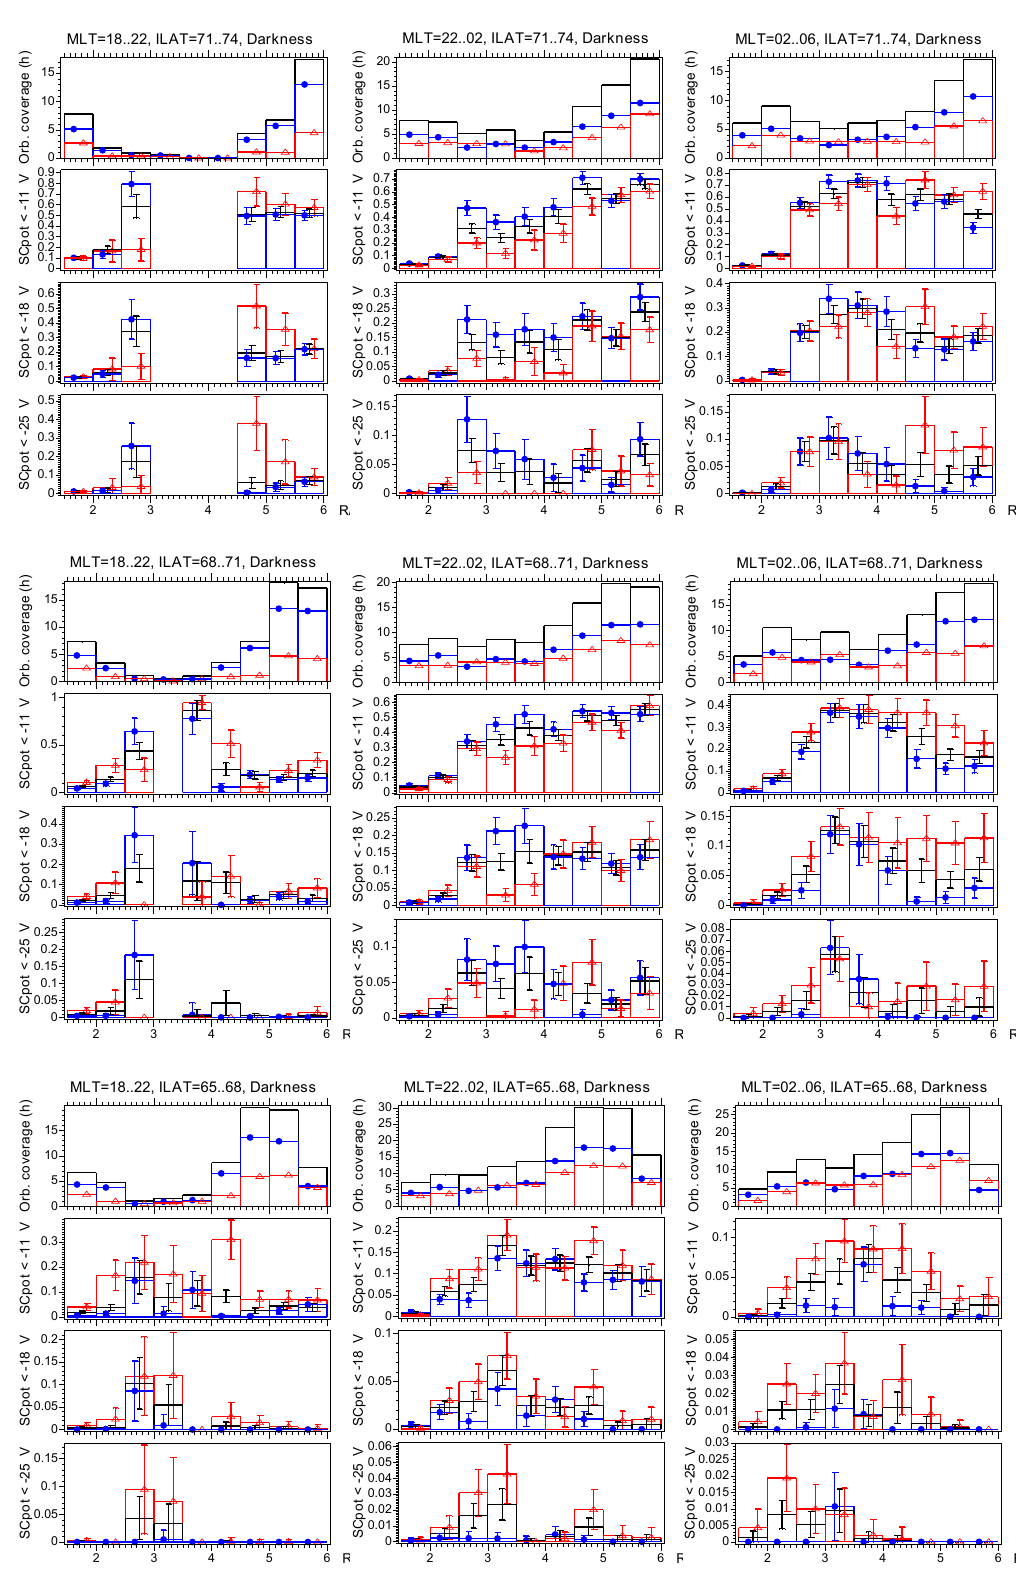
Fig. 5. Occurrence frequency of spacecraft potential being more negative than a threshold. Same format as Fig. 4 but for darkness conditions only and decomposed into three MLT and three ILAT ranges. The MLT and ILAT ranges are shown in the title of each of the nine subplots. MLT changes along the rows and ILAT along the columns. As before, low K p is shown by blue, high K p as red and all K p ’s put together by